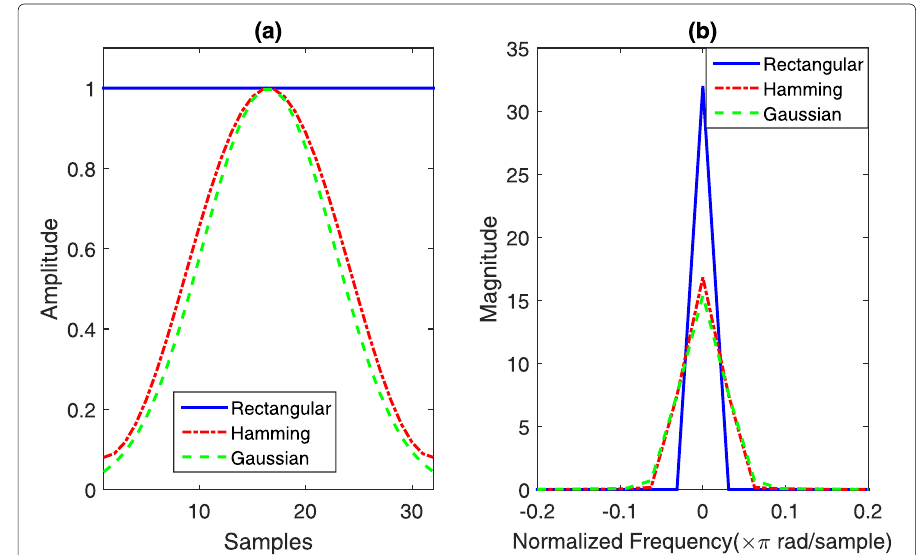
Fig. 6 Time domain and frequency domain of different window functions. a Time domain. b Frequency domain